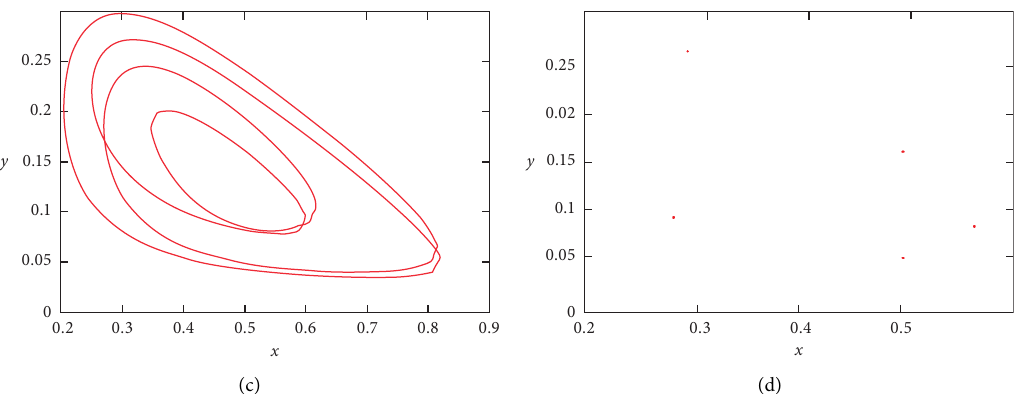
Figure 5: Phase space and its corresponding Poincar´e section of nonlinear chemical reaction with f � 0.00165 and other parameters of Figure 3. (a, b) Quasiperiodic attractor for initial conditions (0.5, 0.5) and (c, d) attractor of period 5 T for initial conditions (0.1, 0.1).